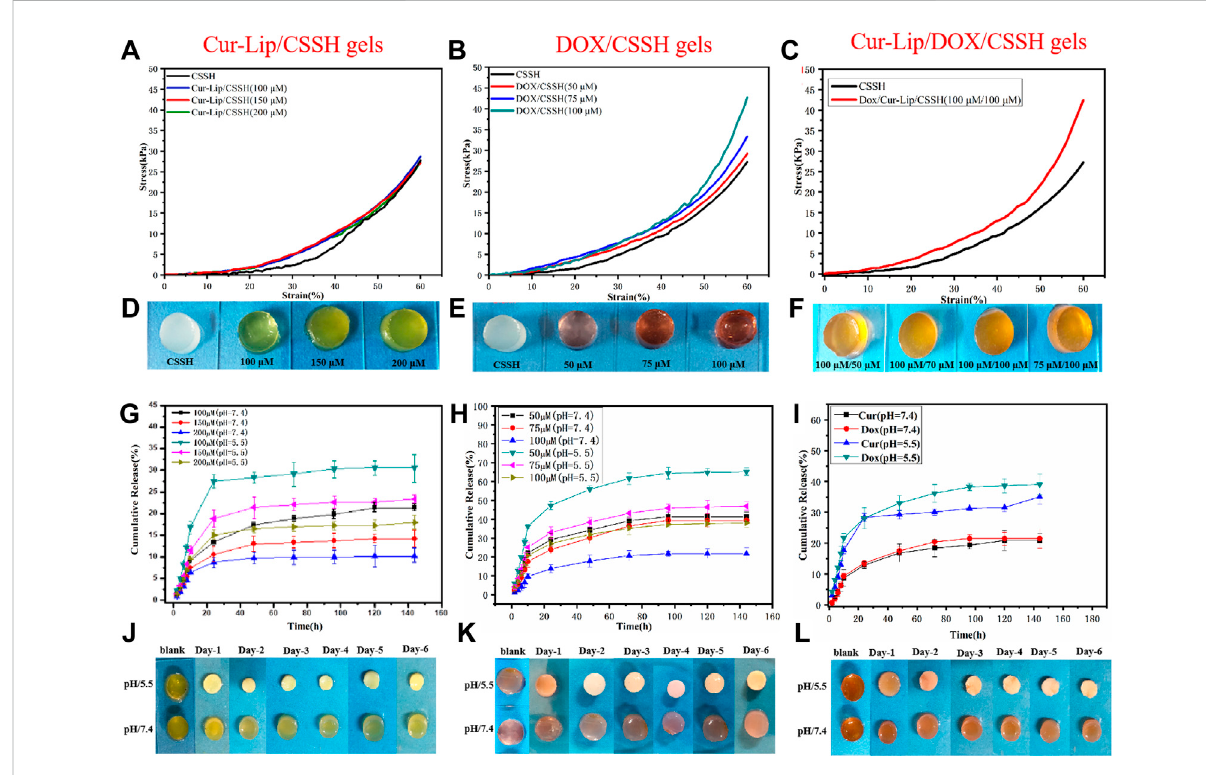
FIGURE 7 Stress ‒ strain curves of the gels (A – C) . Drug release curves of the gels containing different concentrations of drug (G,H) . Drug release curve of the Cur – Lip/Dox/CSSH gels (100 µM/100 µM). (I) Macro images of the gels (D – F,J – L)